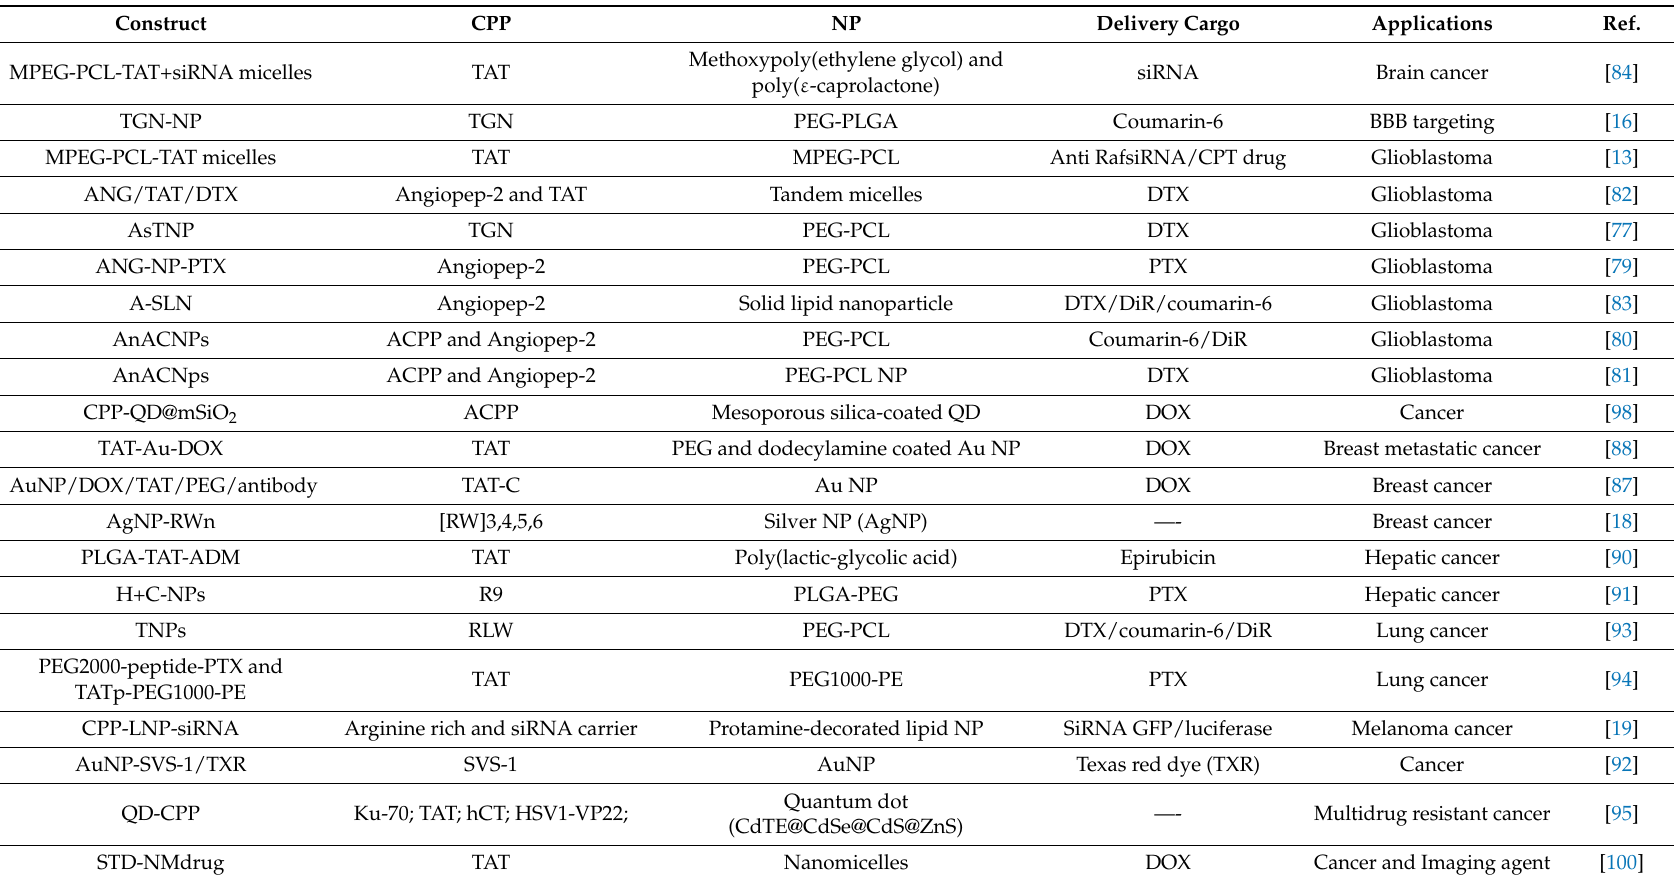
Table 3. Conjugation strategy and different